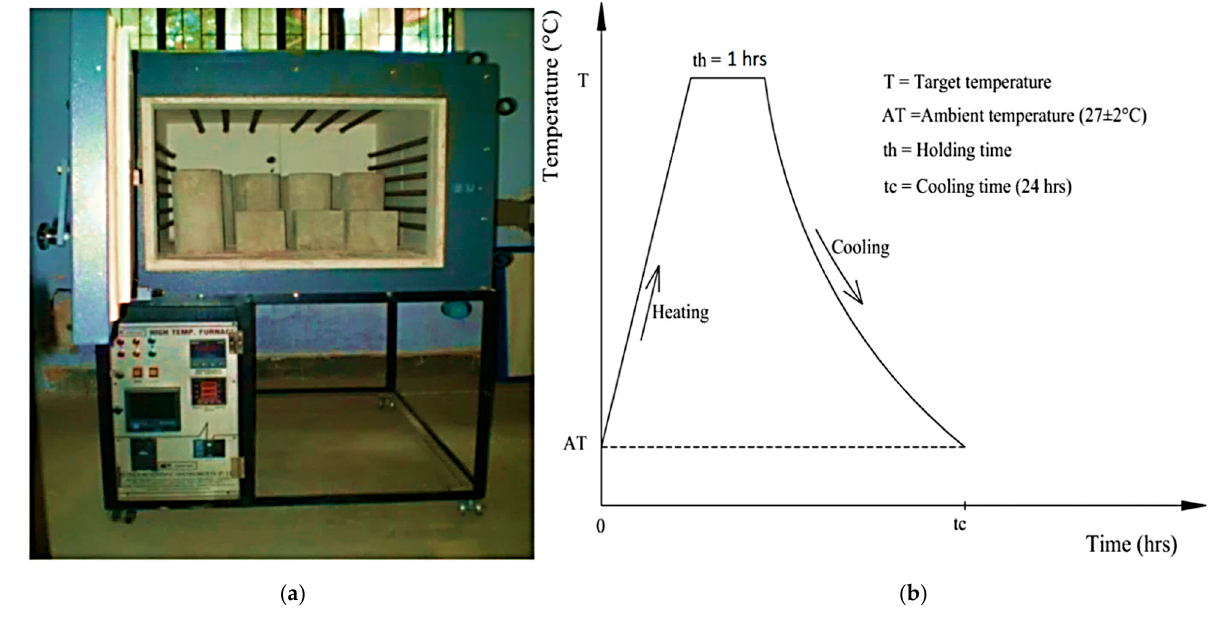
Figure 7. ( a ) High-temperature furnace, ( b ) single heating–cooling cycle curve.